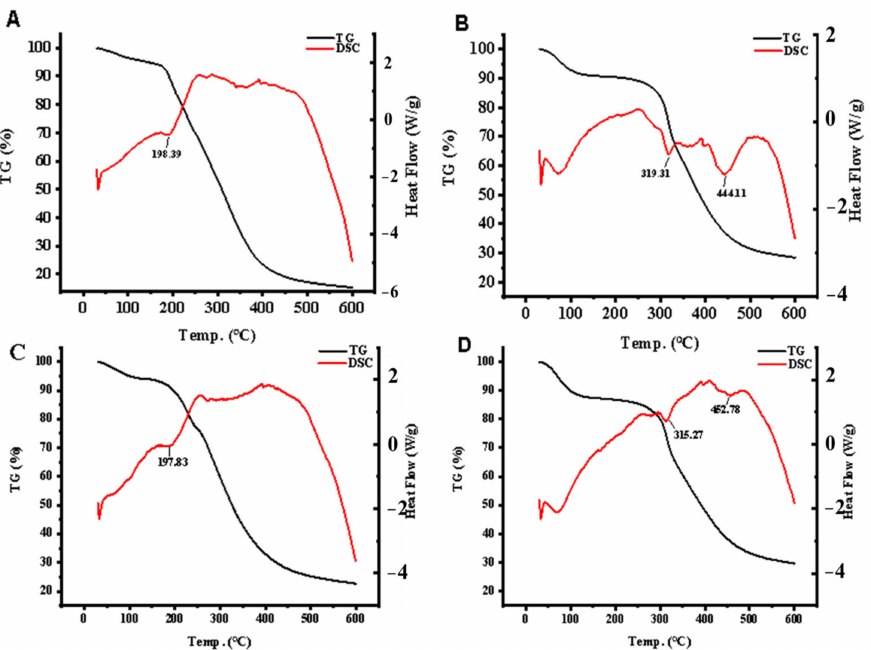
Figure 5. The TG-DSC curves for the peptide and peptide–Ca complexes. ( A : CBP-H, B : CBP-H–Ca, C : CBP, D :